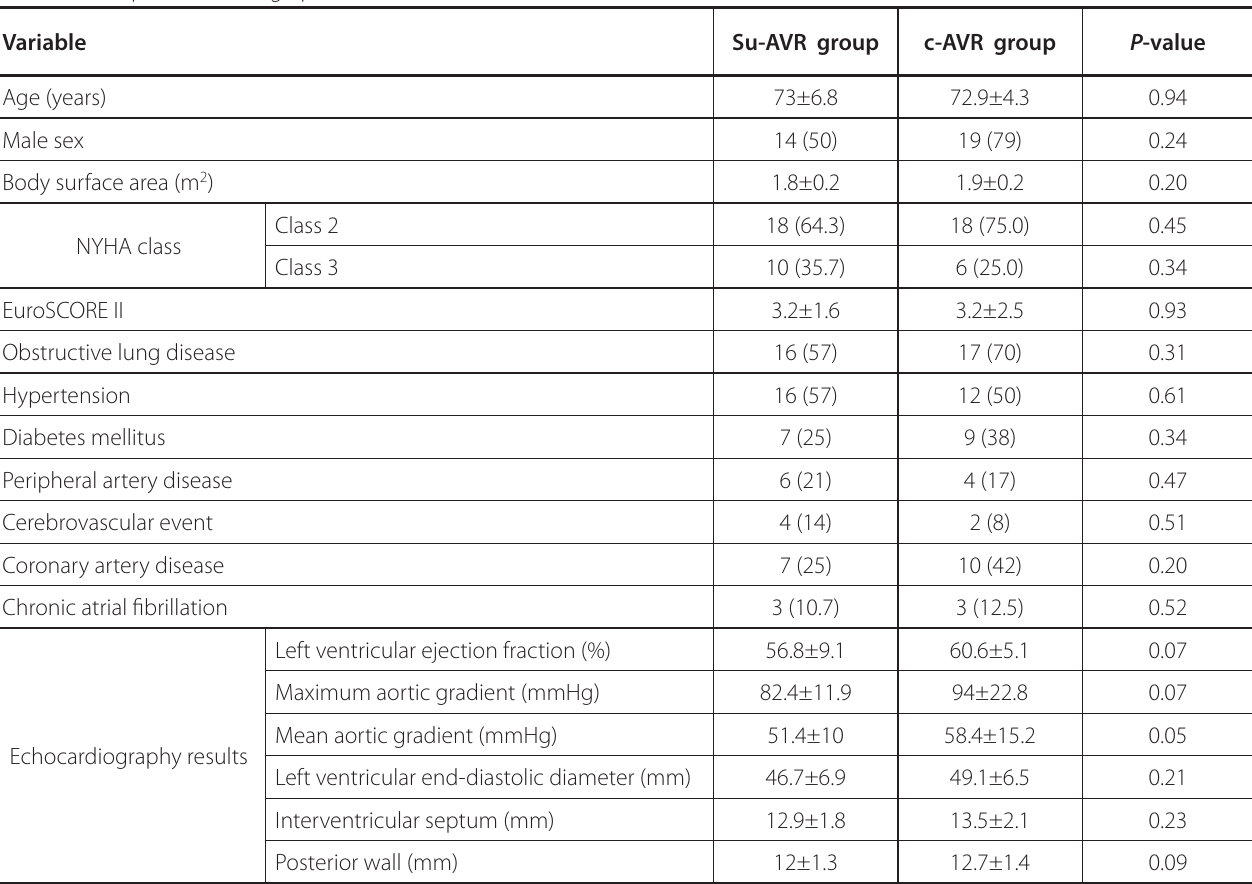
Table 1. Preoperative demographic